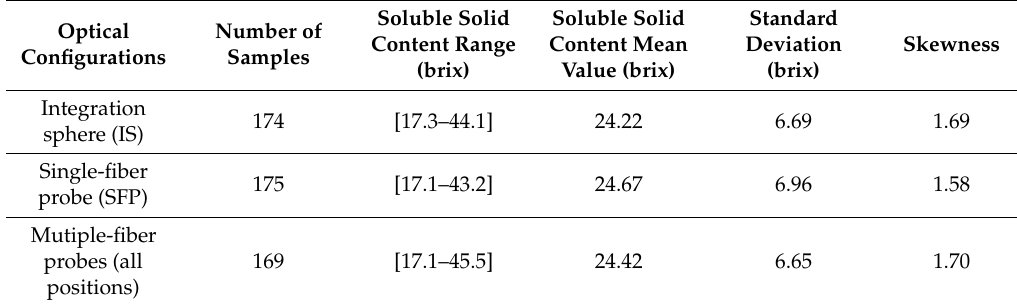
Table 1. Descriptive statistics of soluble solid content values for the di ff erent optical